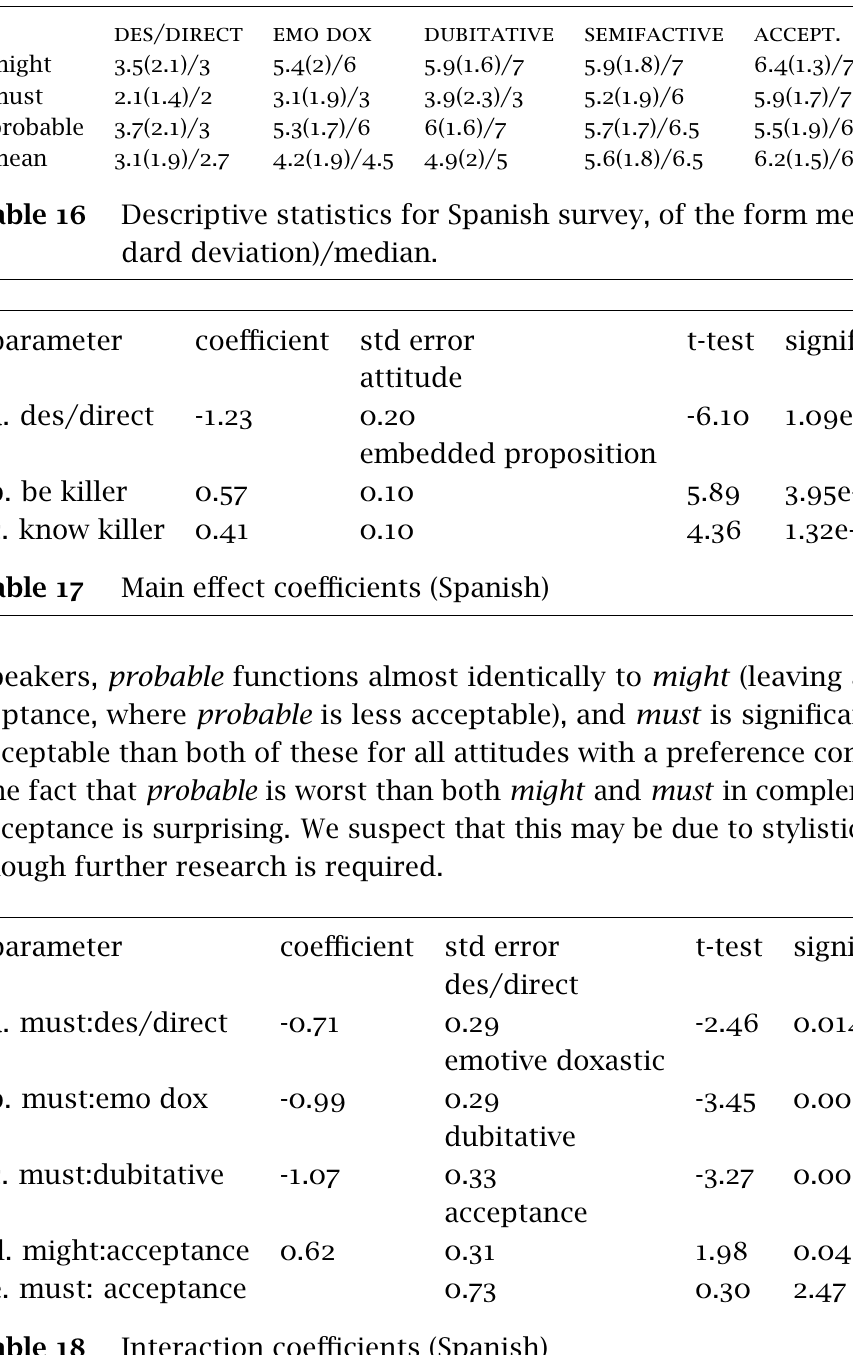
Interaction coefficients